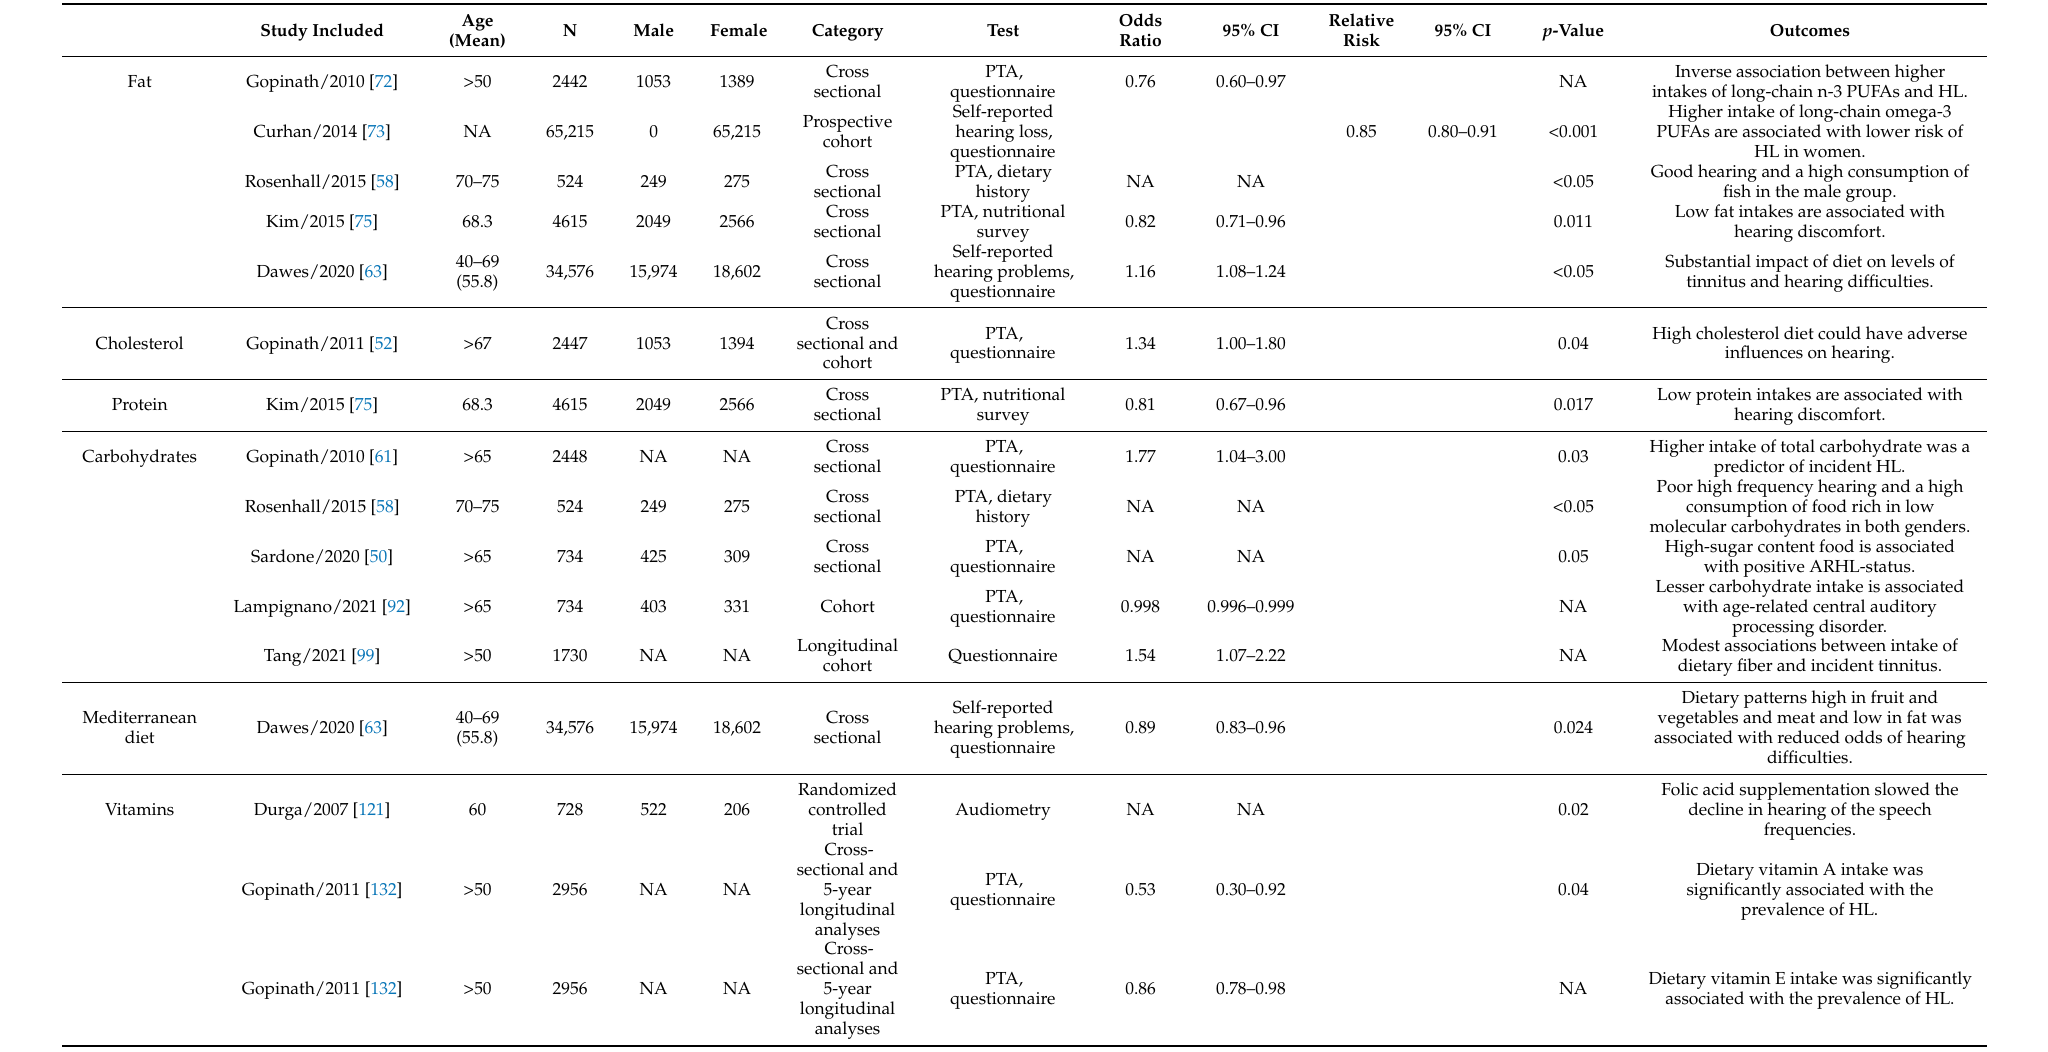
Table 1. The effects of diets on ARHL, ARVL, and related